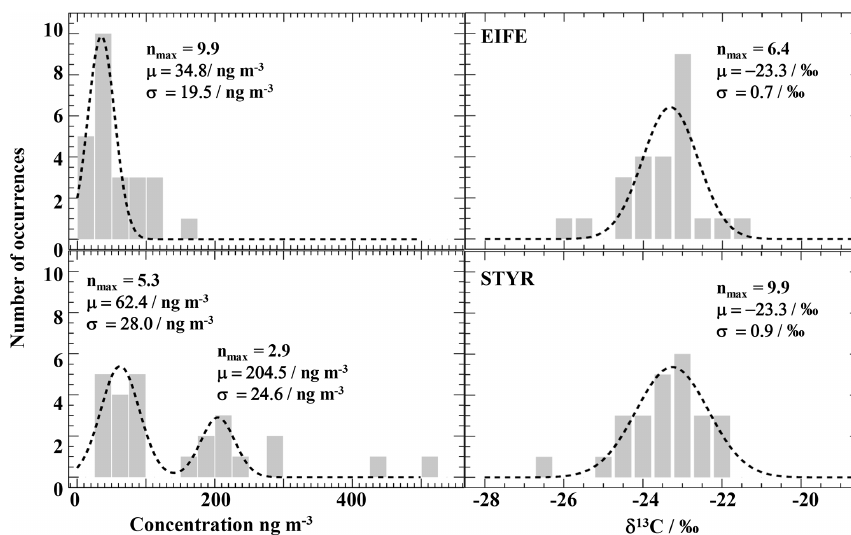
Figure 3. Distribution frequency of the observed levoglucosan concentration and δ 13 C.